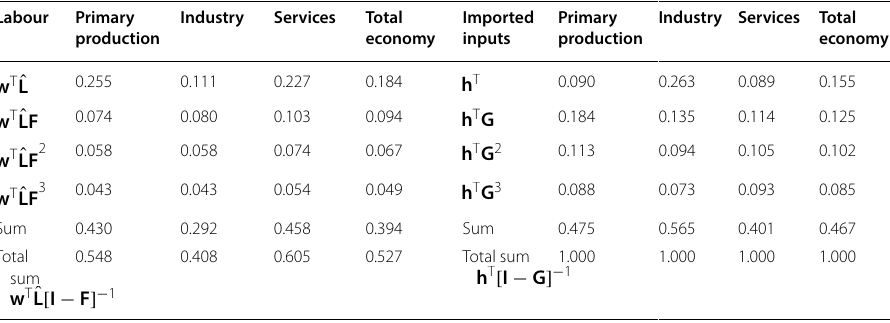
Table 2 Sectoral dated quantities of direct labour and imported inputs; Italy Labour Primary Industry production